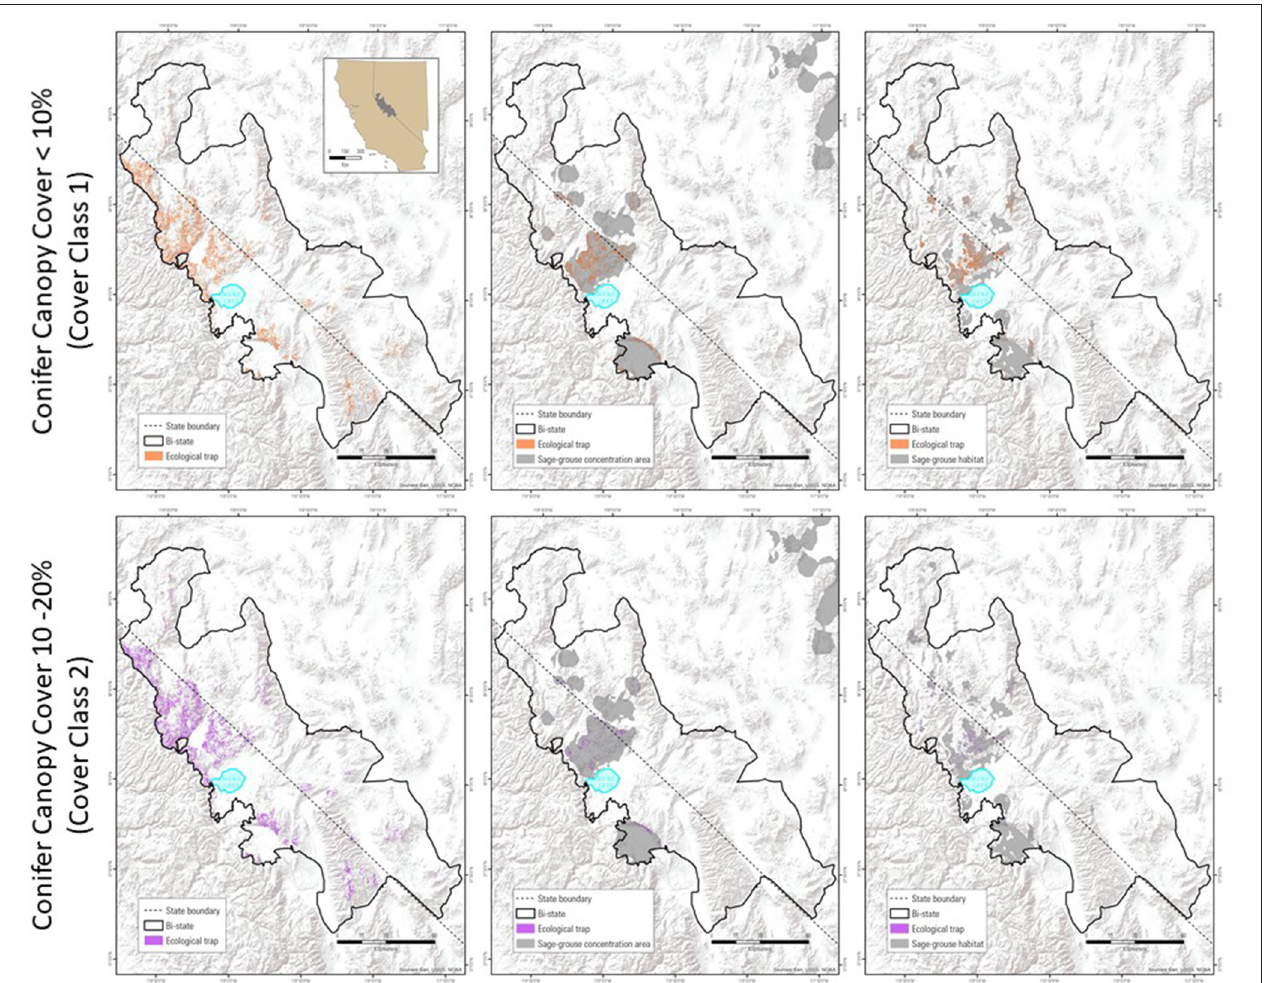
FIGURE 6 | Spatial overlay approach depicting the distribution of possible ecological traps to sage-grouse based on the intersection of cover-class 1 conifers with high RandR (upper row, A ), and further delineated for management priority based on intersections with a lek-only based model of sage-grouse habitat and abundance using SGCAs (B) , and a telemetry-and lek-based model of sage-grouse habitat and abundance (C) . The lower row (D–F) represents ecological traps that could be created by thinning of cover-class 2 to cover-class 1 in high RandR